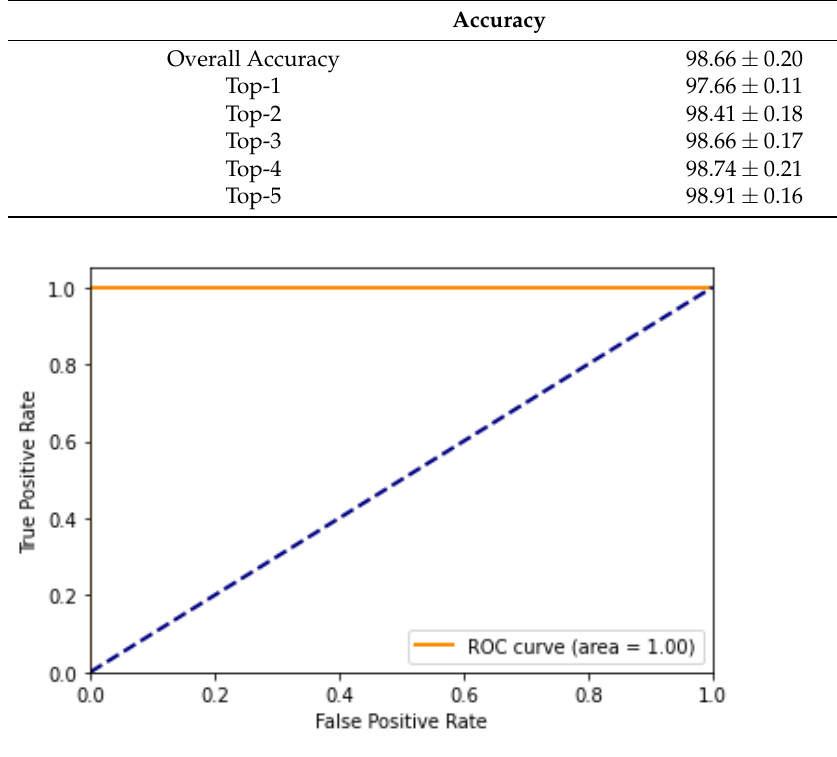
Figure 7. ROC-AUC curve.